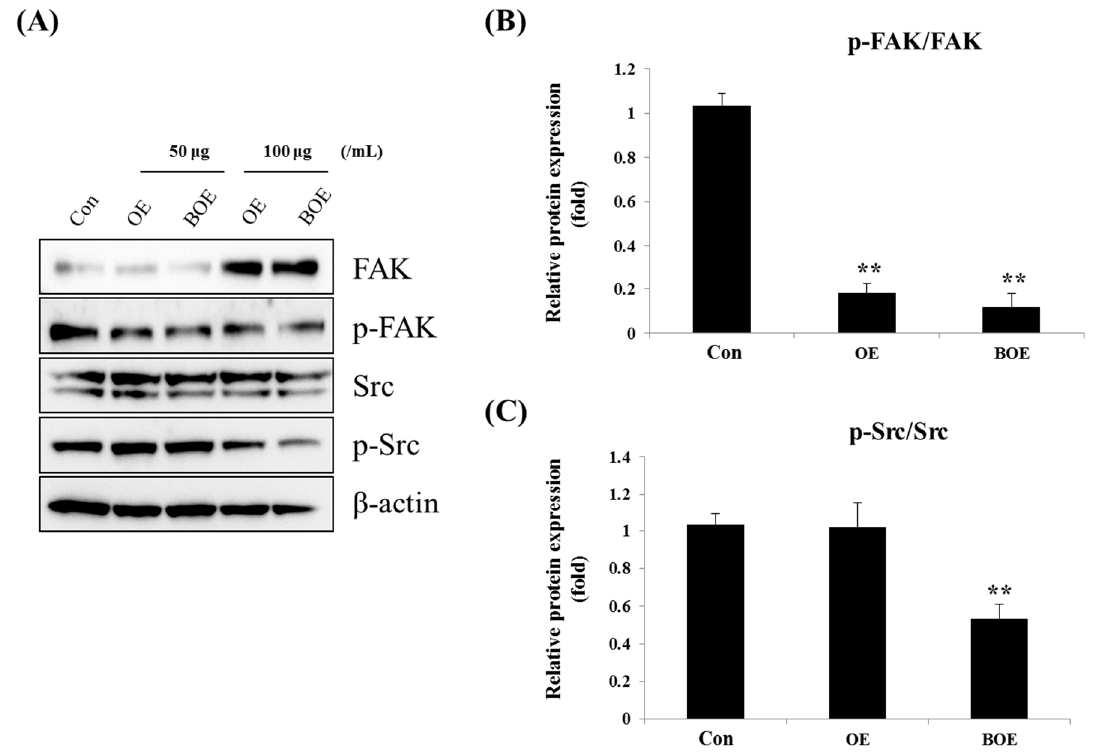
Figure 4. Effects of OE and BOE on the activation of FAK (focal adhesion kinase) and Src. Cells were lysed after treatment with OE or BOE for 24 h. ( A ) Protein expression of p-FAK, total FAK, p-Src, total Src, and β -actin were analyzed via western blotting. The level of phosphorylation of FAK ( B ) and Src ( C ) was measured by fusion solo detector software. Photographs are representative pictures from three independent experiments. p < 0.01 (**). Bars represent mean ± SD.